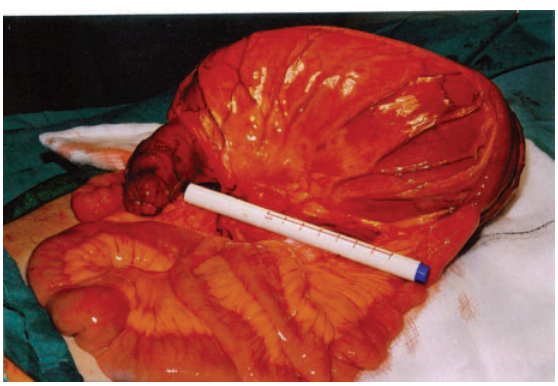
Figure 2. Surgical specimen showing the cyst before resection. Note the small bowel stretched over the cyst. Also seen is the blind ending projection from the cyst wall.